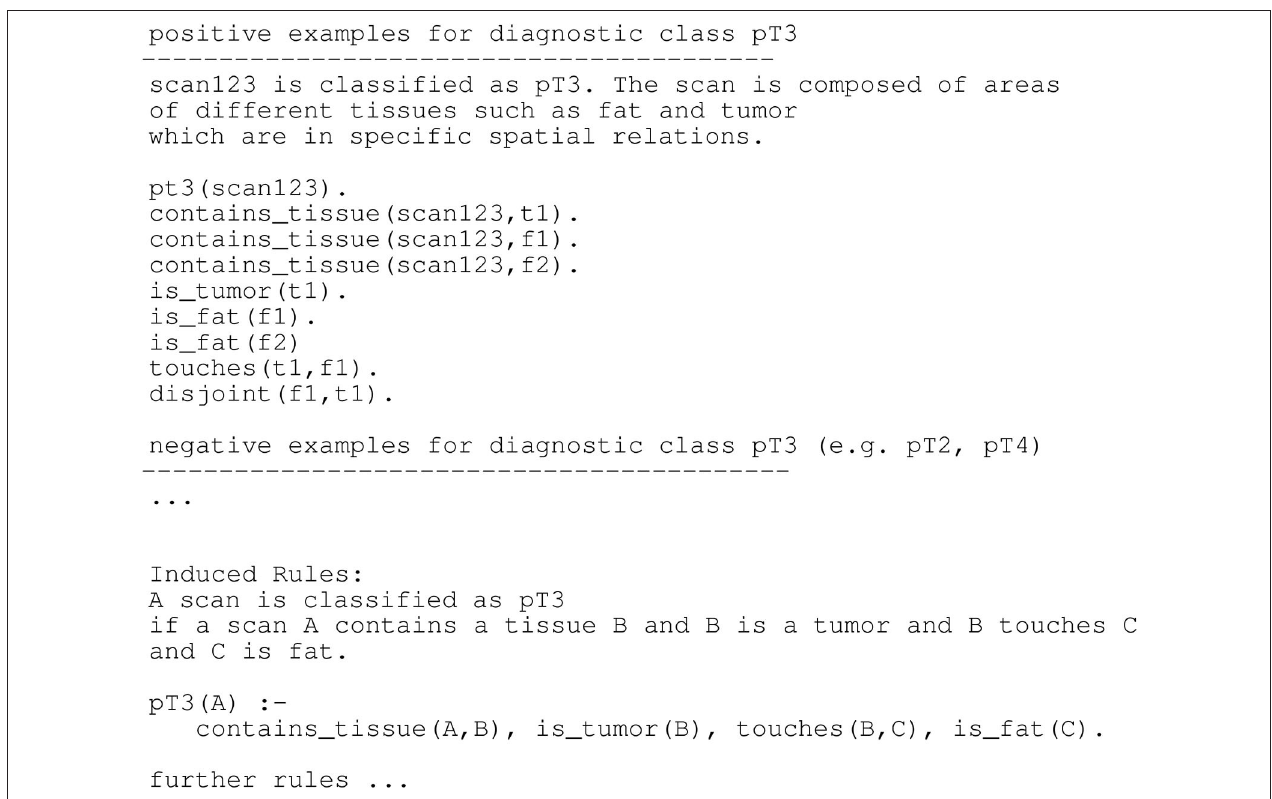
FIGURE 7 | Training examples and learned rules for a hypothetical diagnostic domain of colon cancer (Schmid and Finzel, 2020).